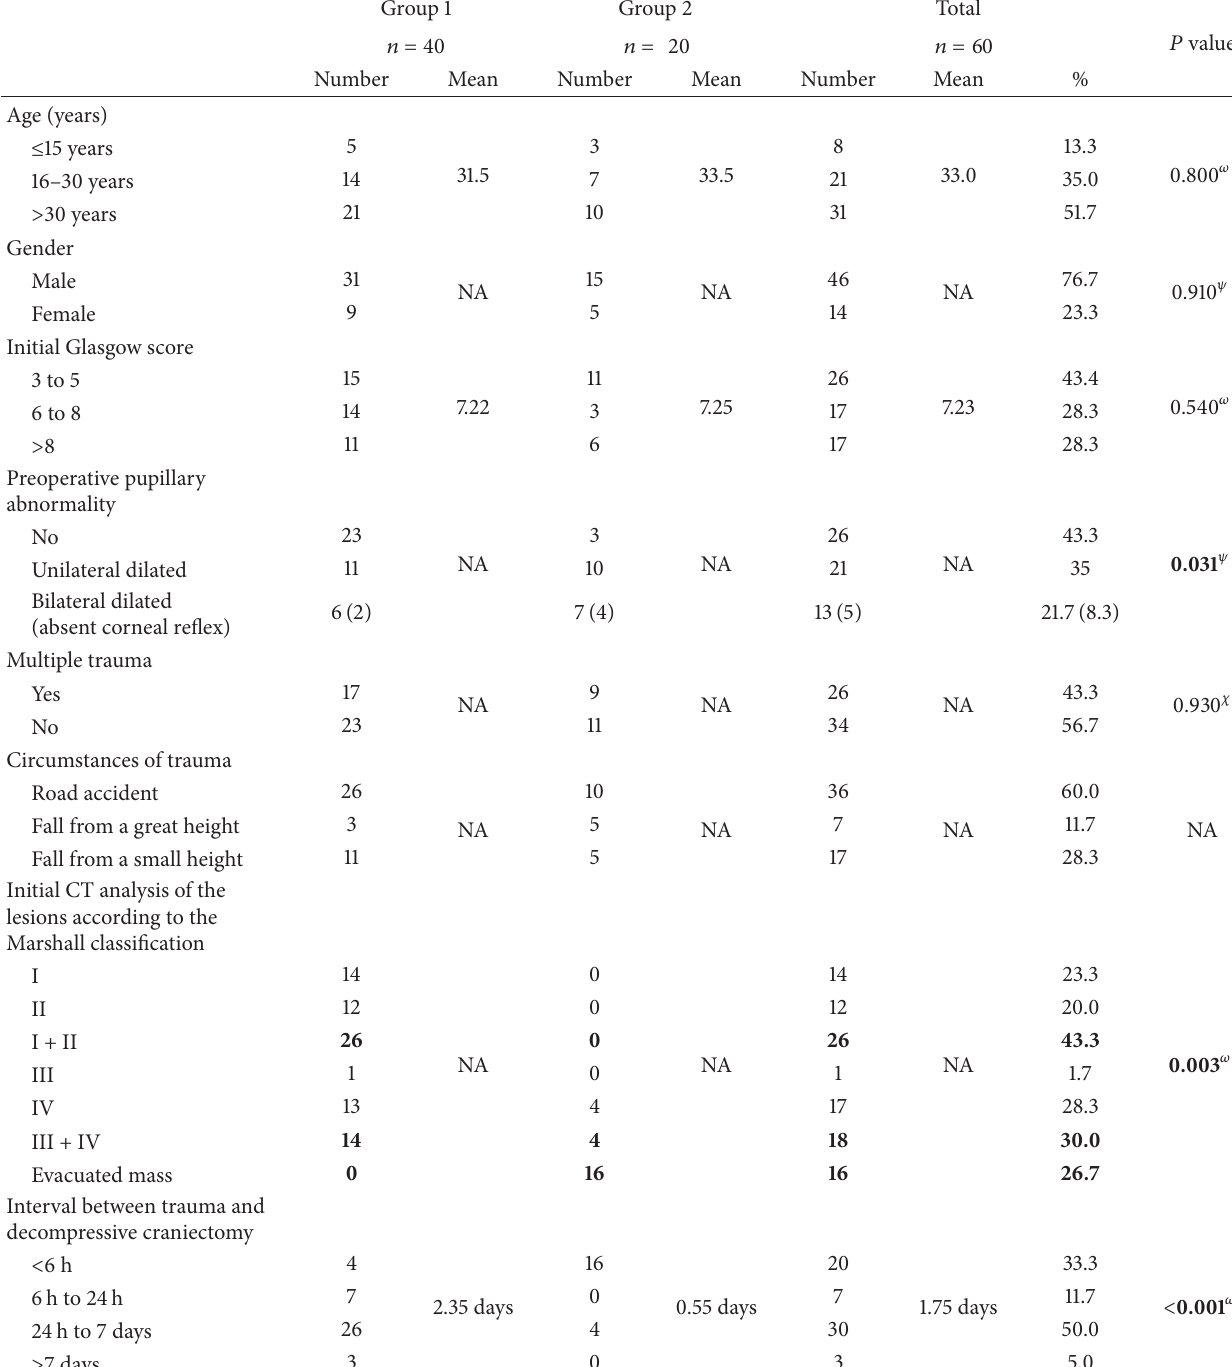
Table 1: Patient characteristics in group 1 and group